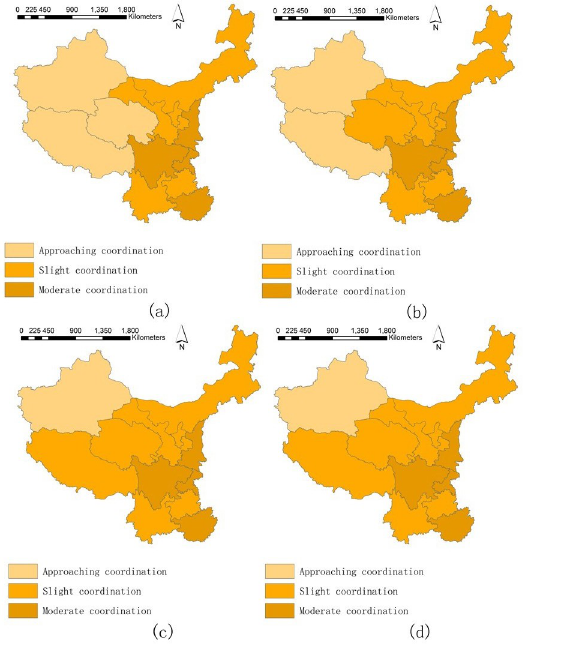
Fig 9. Spatial variation predictions of COU. (a-d)